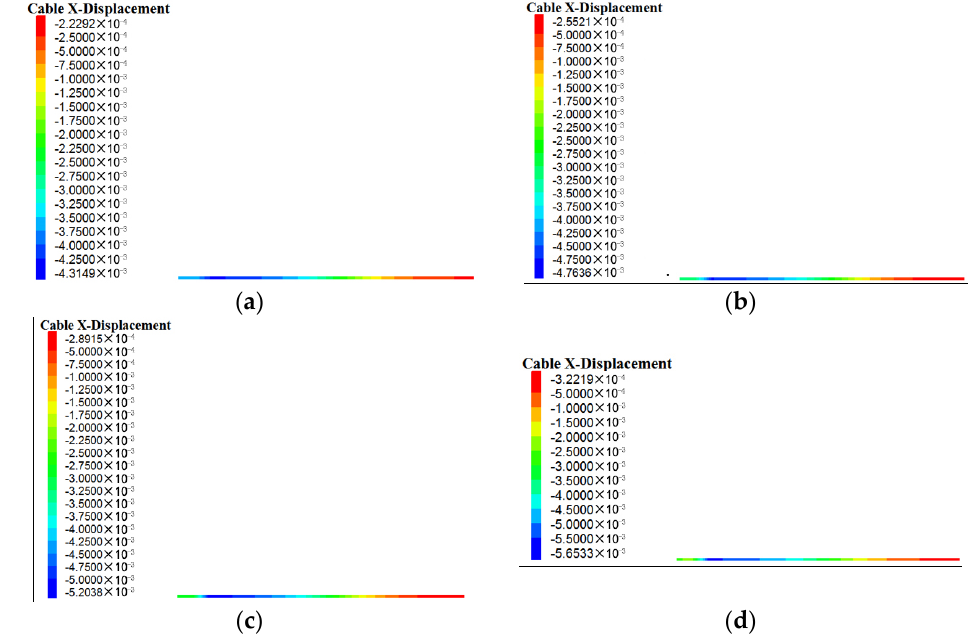
Figure 10. Cloud image of the cable displacement under different prestress (with fracture aperture of 4 mm). ( a ) Prestress = 20 kN; ( b ) prestress = 40 kN; ( c ) prestress = 60 kN; ( d ) prestress = 80 kN.